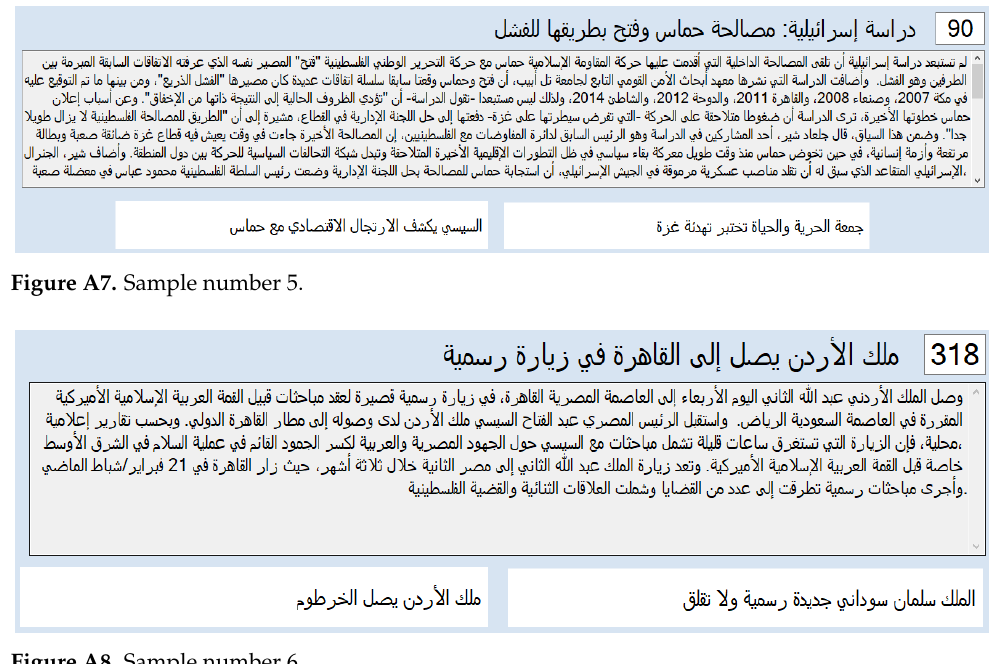
Figure A8. Sample number